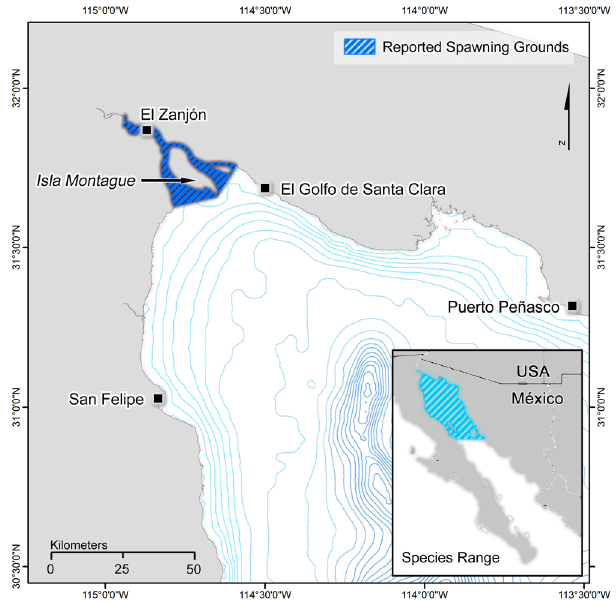
Figure 1. Species range and spawning grounds of Gulf Corvina ( Cynoscion othonopterus ). The species range extends from the Midriff Islands to the northern limit of the Gulf of California (inset map). During the months of February to early June, the reproductive population migrates northward to the only reported spawning grounds in the Colorado River Delta. The map is adapted by permission from Macmillan Publishers Ltd: [SCIENTIFIC REPORTS] (Erisman et al . 43 ), copyright